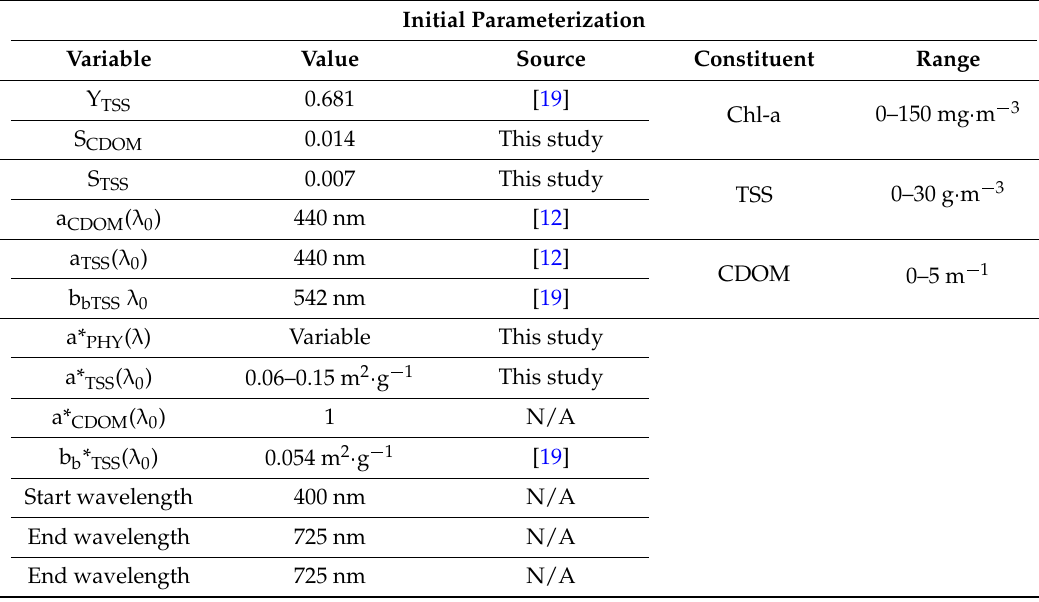
Table 1. Initial Parameters used in the full semi-analytical